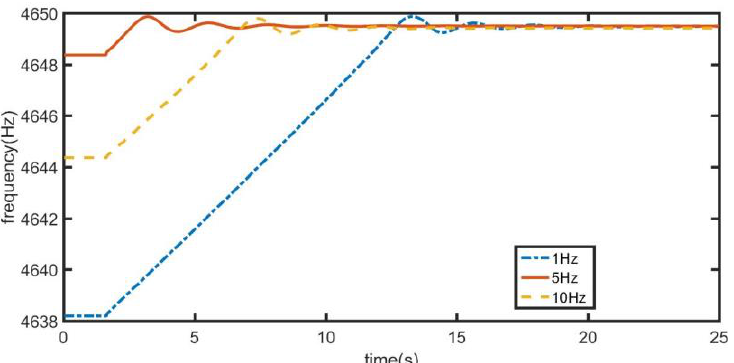
Figure 19. Variation of vibration frequency of driving mode under different initial frequencies.